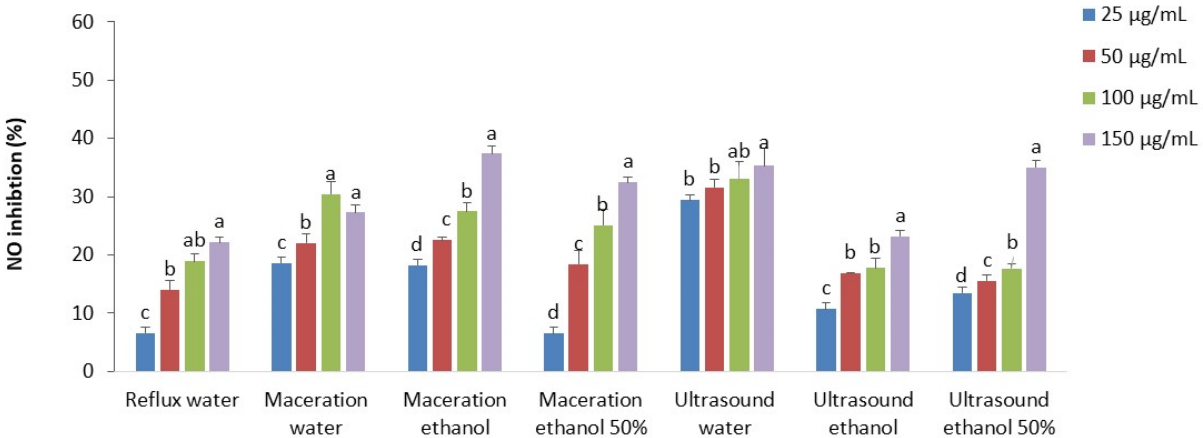
Figure 2. Anti-inflammatory activity of A. unedo extracts from different extraction methods (mean ± SD, n = 3 replicates). Cells were incubated with 25–150 μ g/mL extract and Lipopolysaccharide (LPS). After a 24 h LPS stimulation, the cell-free supernatants were collected and assayed for nitric oxide (NO) levels. For the same extraction method, different letters (a, b, c, d) mean significant differences between extract concentrations using the Duncan test at the probability level of p < 0.05.